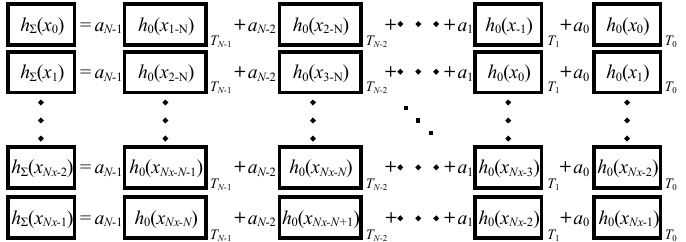
Figure 6. Illustration of the computation procedure for Equation (23) (symbols y , z , and t are omitted).